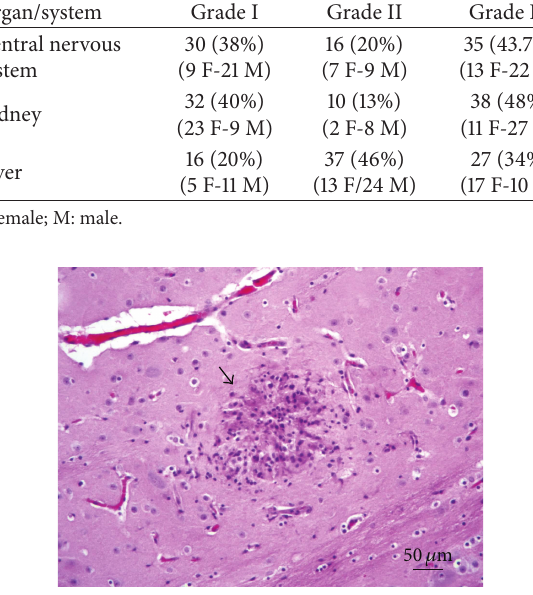
Figure 3: Brain. Lesion Grade III. Severe nonsuppurative gran- ulomatous reaction (arrow) composed by microglial cells and mononuclear cells (lymphocytes). Hematoxylin and eosin. and gender were not statistically significant ( 𝜒 2 = 5.64; 𝑝 = 0.05 ). Further, adjacent to Type C granulomas, we observed both intact and ruptured parasitic cysts releasing infective spores directly into the nervous tissue (Table 1).